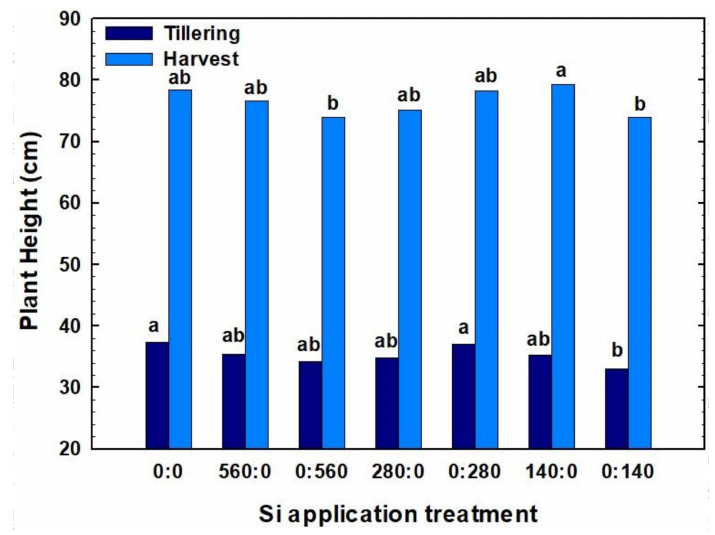
Figure 1. Effect of different silicon (Si) rates and application time on winter wheat height at tillering and before harvest in 2017. Treatments are designated in the format x:y, in which x and y are the fertilizer Si rates in kg Si ha − 1 applied at planting and at tillering, respectively. Bars within the same year followed by the same letter are not significantly different ( p > 0.1) based on a Duncan’s multiple range test.